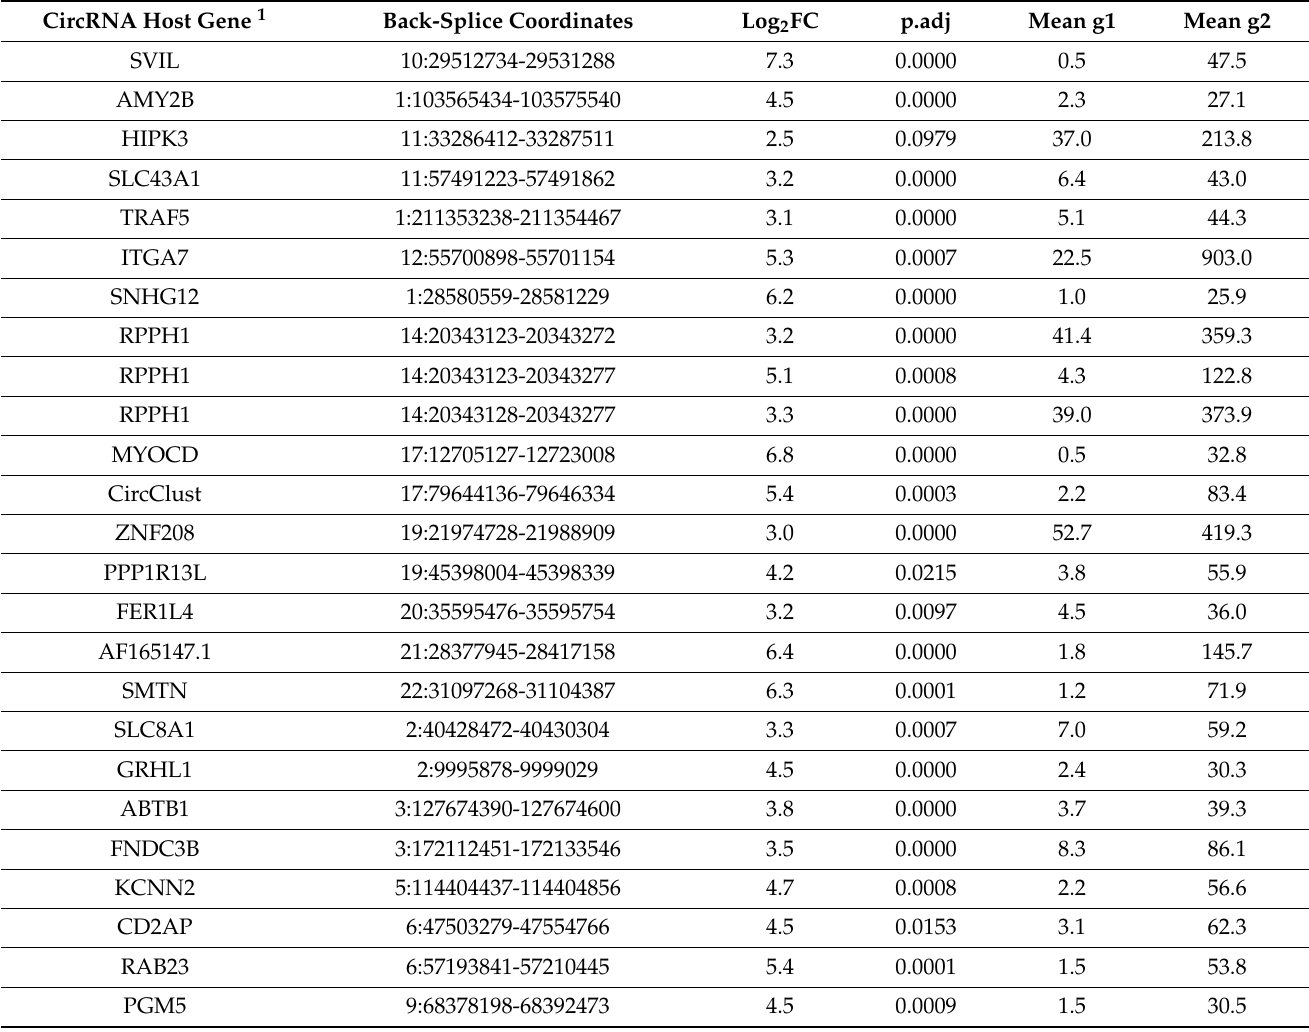
Table 2. Top 25 circRNAs discriminating better among sample groups. For each circRNA, identified by the circRNA host-gene name and the back-splice junction genomic coordinates (BSJ), the average expression in the two sample groups (g1 and g2) are indicated along with the circRNA fold change in base-2 logarithm (Log 2 FC) and the adjusted p -value (p.adj) of differential